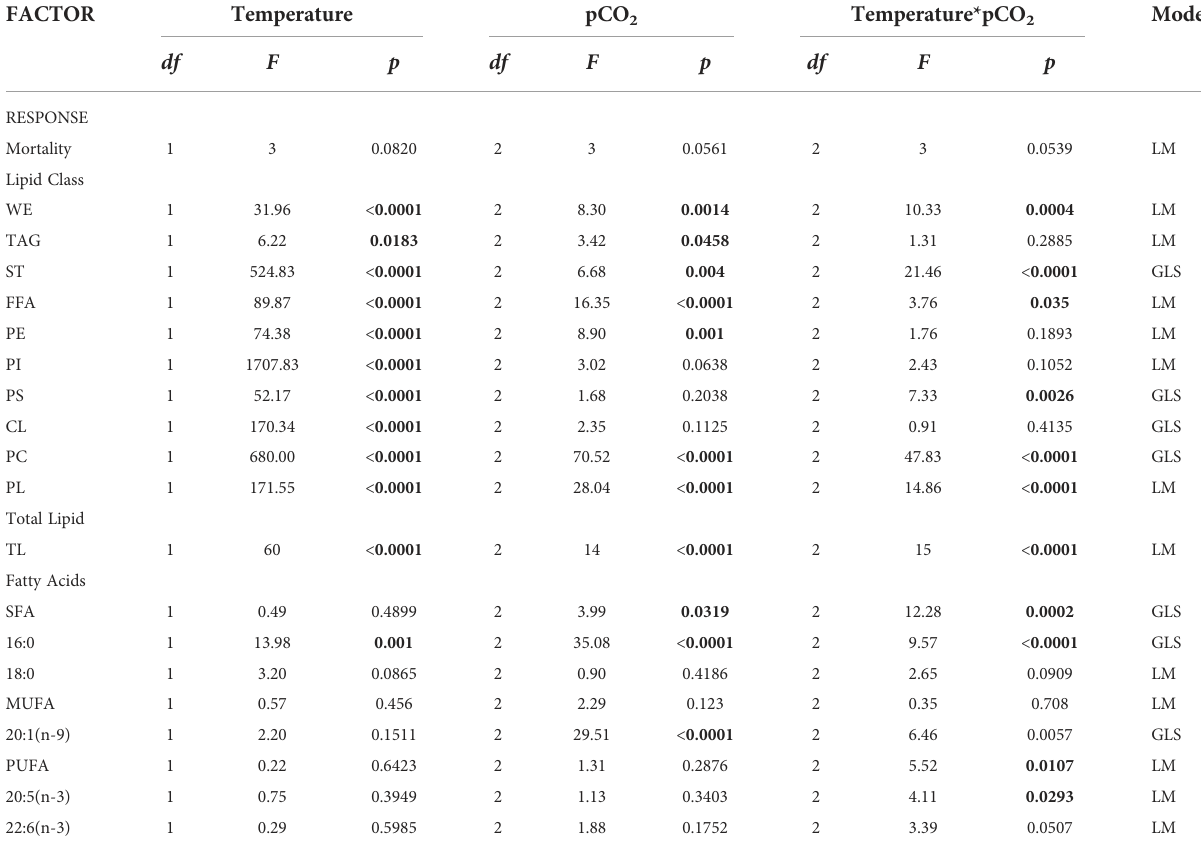
TABLE 2 Summary of two-way ANOVA statistics and applied model for each response variable (LM, linear model; GLS, Generalized Least Squares).